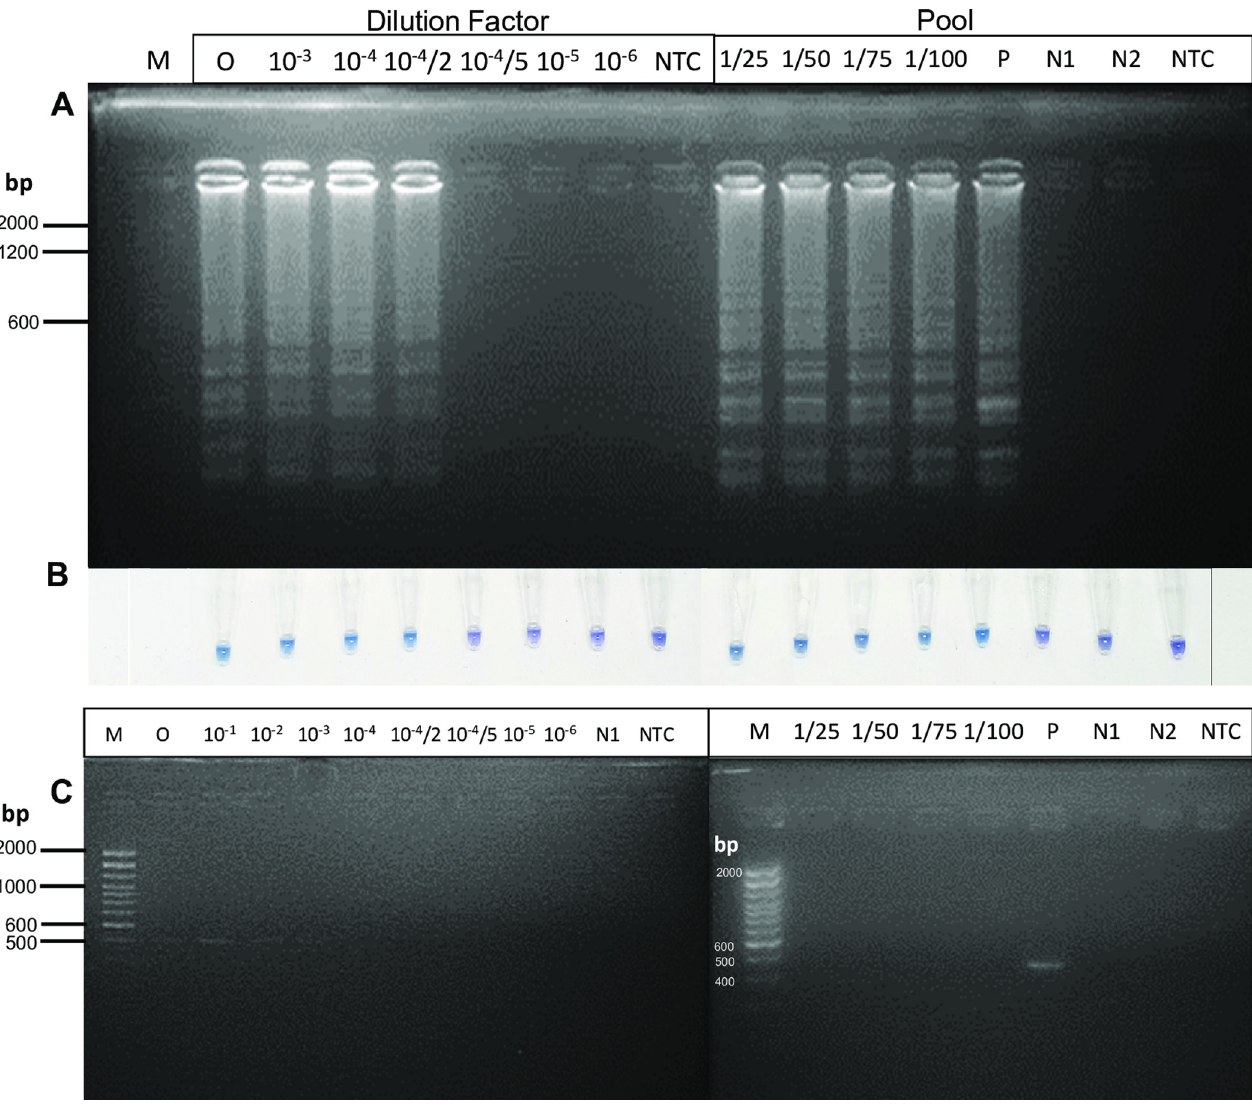
Fig 3. Sensitivity of LAMP (A and B) and PCR (C) detections with sample dilution experiment (Left) and mosquito pool sample experiment (Right). LAMP assay with ethidium bromide-stained gel (A) and HNB indicator (B) of a fold-dilution of an individual crude boiling Aedes aegypti ( w AlbB-TH) sample (182 ng/ μ l, 260/280 = 1.90, 260/230 = 0.99) diluted 10 − 1 –10 − 6 times (6.4 units of Bst 2.0 DNA polymerase, 65˚C for 90 min and 80˚C for 10 min, volume 10 μ l). Polymerase chain reaction with wsp primers (691R and 183F) of the same dilution (C). (O) is a non-diluted original sample, (P) is Wolbachia trans-infected Ae . aegypti ( w AlbB-TH), (N1) is wild-type Ae . aegypti (Aae-JJ), (N2) is 100 wild-type Ae . aegypti (Aae-JJ), (NTC) is no template control, (M) is Invitrogen 100 bp DNA Ladder. For mosquito pooled experiment, the ratio of 1/25 indicates the DNA extraction was performed with one Wolbachia trans-infected Ae . aegypti and 24 wild-type Ae . aegypti . Other pooled samples included 1/50, 1/75, and 1/100, which were equivalent to one w AlbB-TH mosquito in 49, 74, and 99 Aae-JJ,